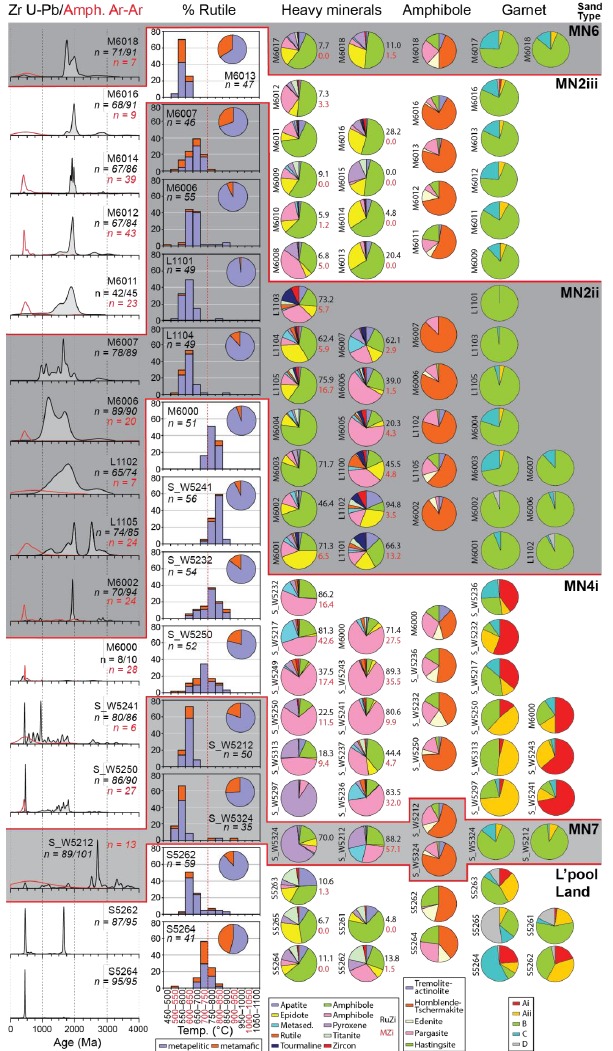
Figure 2. (overleaf) Heavy minerals, mineral chemistry, and isotopic age results. Zircon U–Pb and amphibole Ar–Ar ages are presented as KDE spectra. Note that only the 90% concordant zircon U–Pb ages are plotted, meaning that discordant Archaean–Palaeoproterozoic ages are underrepresented. The relative abundance of metapelitic and metamafic rutile (differentiated following [26]) is shown as bar and pie charts. The red line marks the division between amphibolite/eclogite and granulite-facies temperature conditions (determined following [27]). The heavy mineral components, amphibole assemblage, and garnet assemblage results are presented as pie